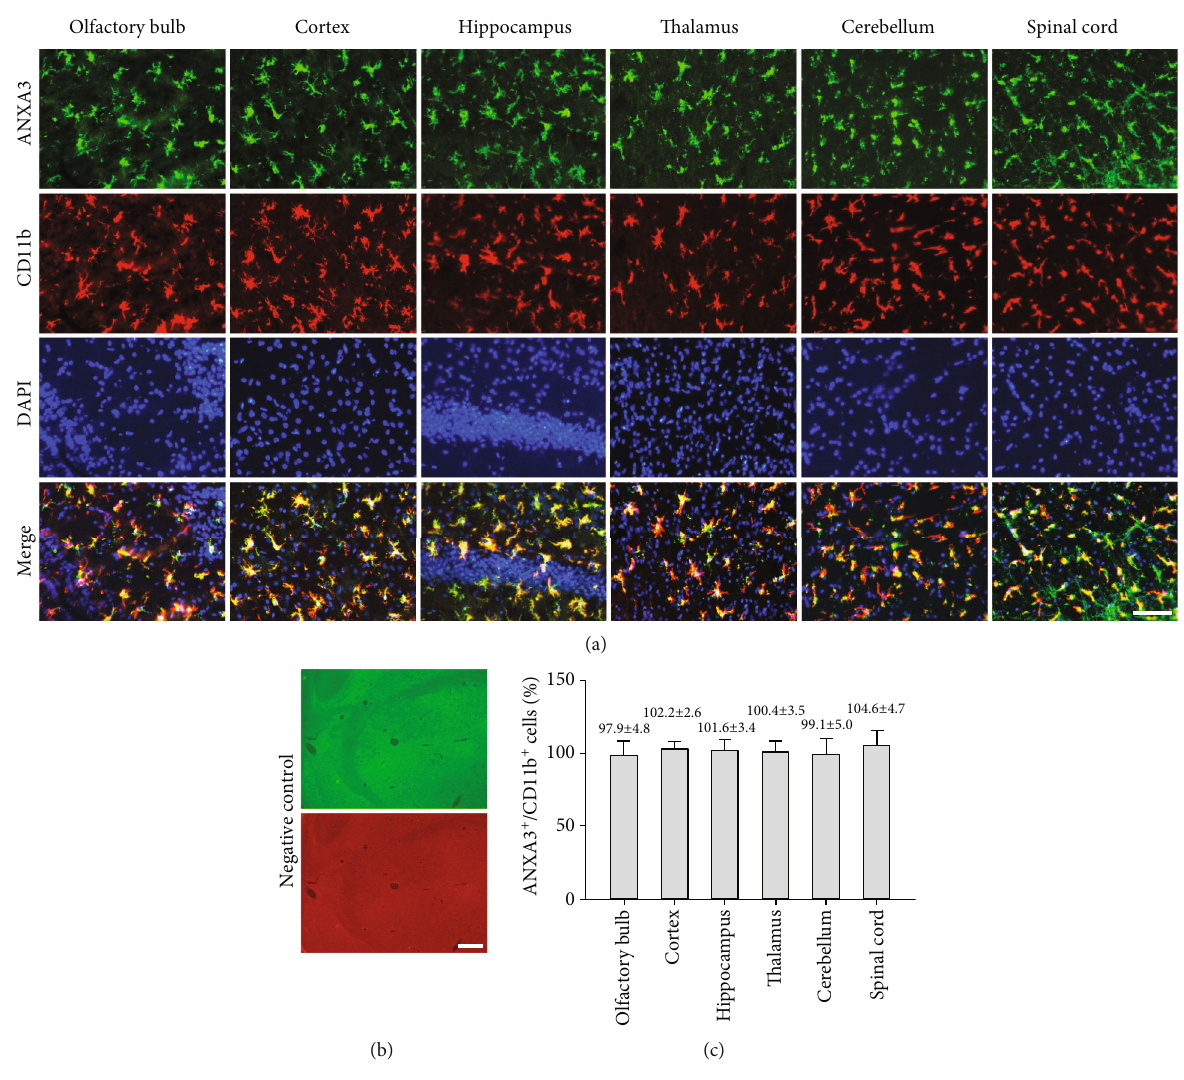
Figure 3: Colocalization of ANXA3 and CD11b in di ff erent regions of the CNS. (a) Representative immuno fl uorescence images of microglia labeled by ANXA3 and CD11b in the olfactory bulb, cortex, hippocampus, thalamus, cerebellum, and spinal cord of adult rats (3 months). Scale bar = 40 μ m . (b) Images of the negative control (without primary antibody). Scale bar = 100 μ m . (c) Quantitative analysis of ANXA3 + /CD11b + microglial cells in di ff erent regions of the CNS. The ANXA3 + /CD11b + are the number of ANXA3-positive cells/the number of CD11b-positive cells in the same randomly selected fi eld of view. The data are presented as the means ± SD and were analyzed by one-way ANOVA with Tukey ’ s post hoc test. n = 5 per group. Cells in fi ve randomly selected fi elds were